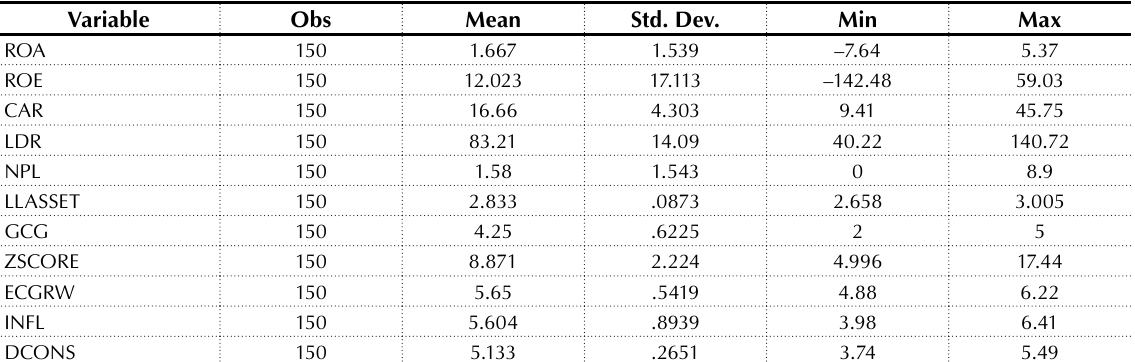
Sources: Indonesia capital market directory ICMD and FSA